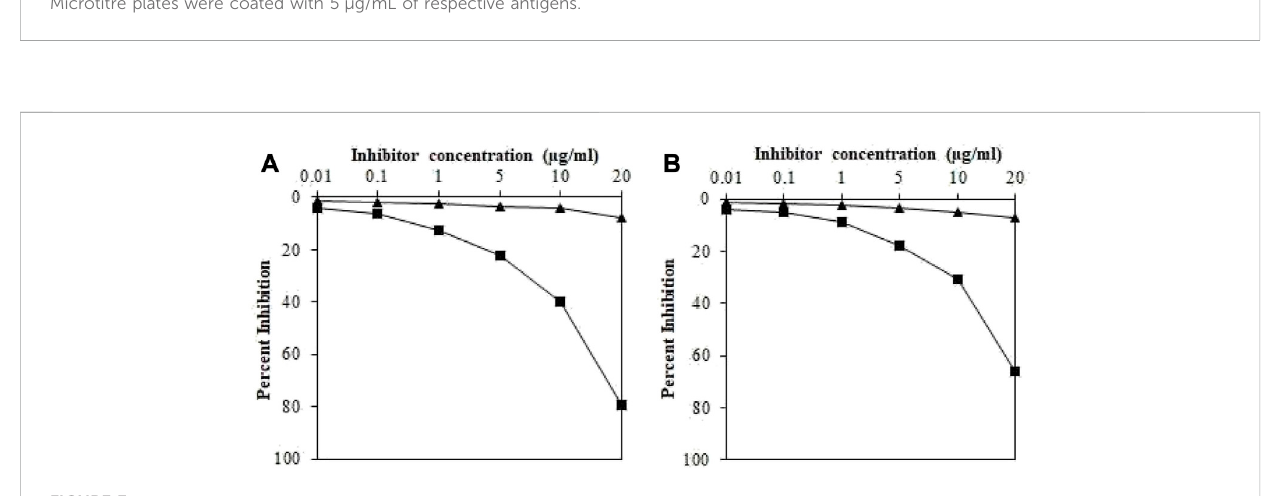
FIGURE 3 Inhibition ELISA of IgGs raised against OH-pDNA (A) and pDNA (B) ( ■ )and IgGs from pre-immune sera ( ▲ )samples. The 96-well plates were coated with pDNA and OH-pDNA (5 μ g/mL). All the samples were run in triplicates.